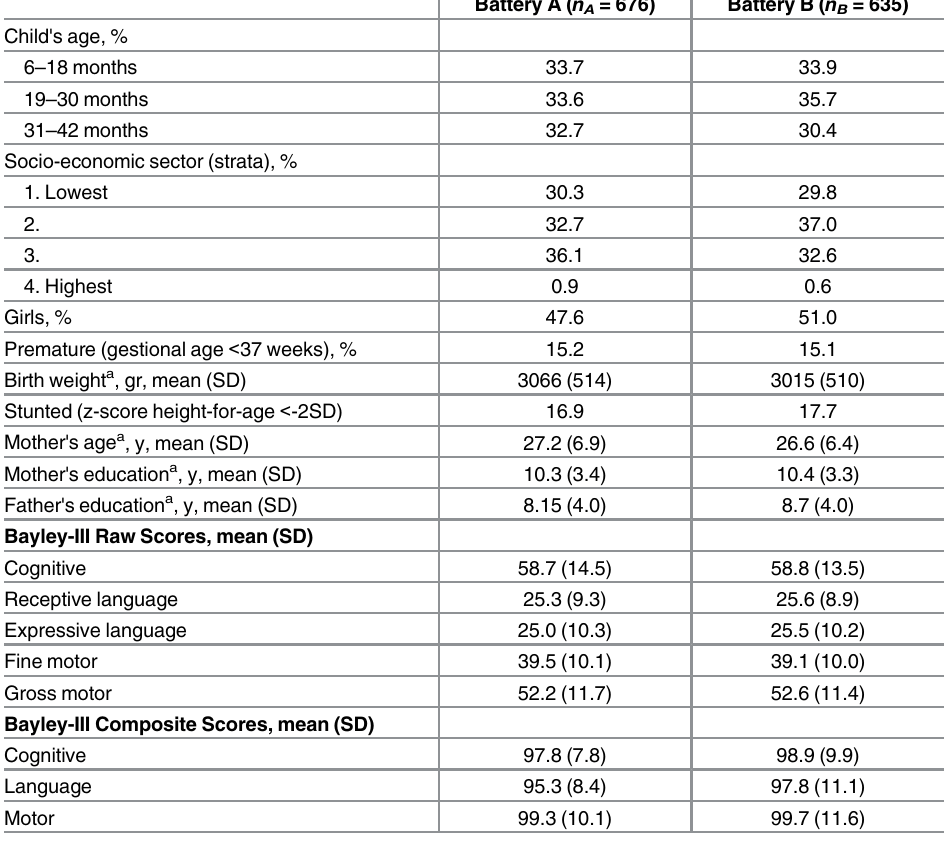
Table 2. Characteristics of Children in the Study Sample by